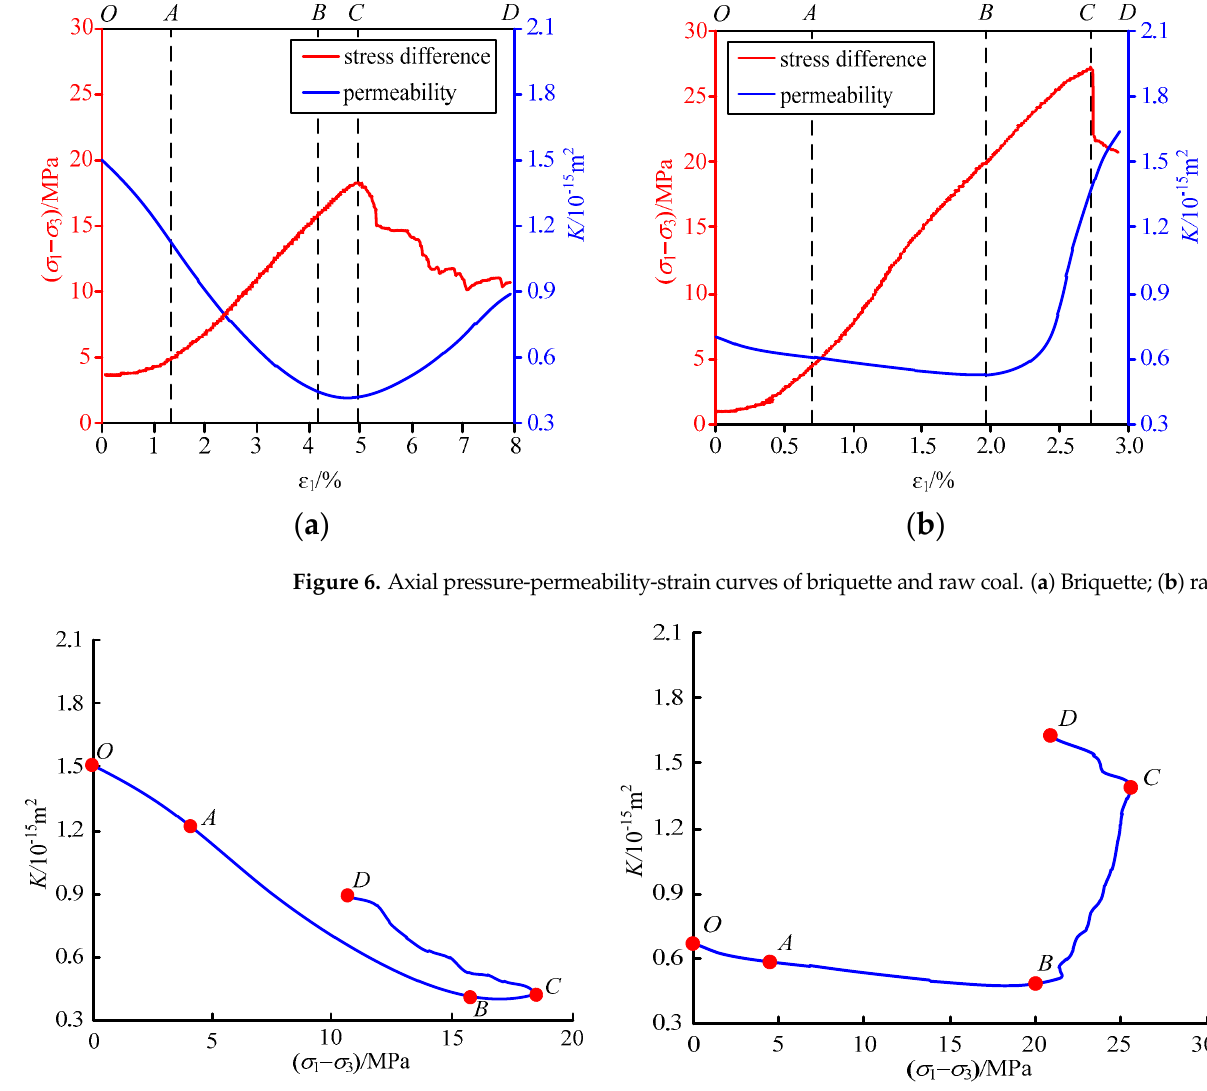
Figure 6. Axial pressure-permeability-strain curves of briquette and raw coal. ( a ) Briquette; ( b ) raw coal.